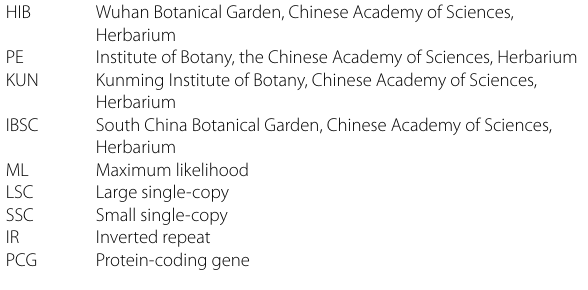
a Genes with one intron b Genes with two introns c Two gene copied in IR regions